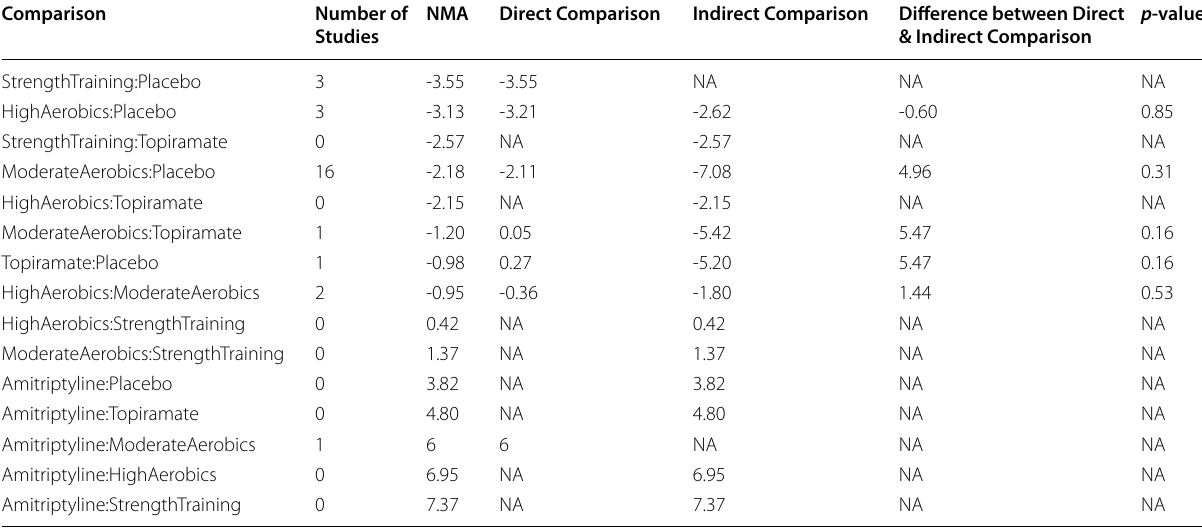
Table 1 Assessment of inconsistency between direct and indirect comparisons of interventions. Direct, NMA, and indirect values represent effect sizes of mean difference between active and placebo arms in monthly migraine frequency from baseline to end of intervention. NMA network meta-analysis =